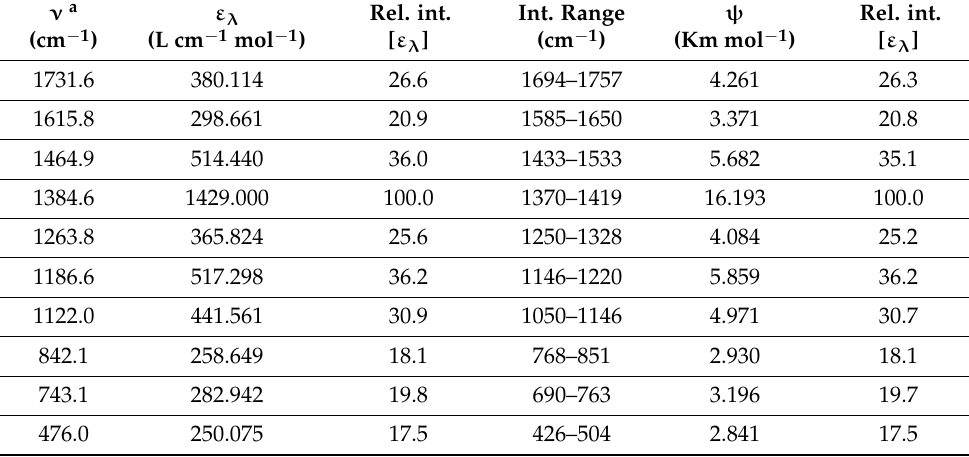
Table 2. The molar extinction coefficients and the integrated molar extinction coefficients of the main convoluted IR maxima of C 84 -D 2 :22, in the appropriate entire integration ranges, with all surrounding absorption shoulders, and their relative